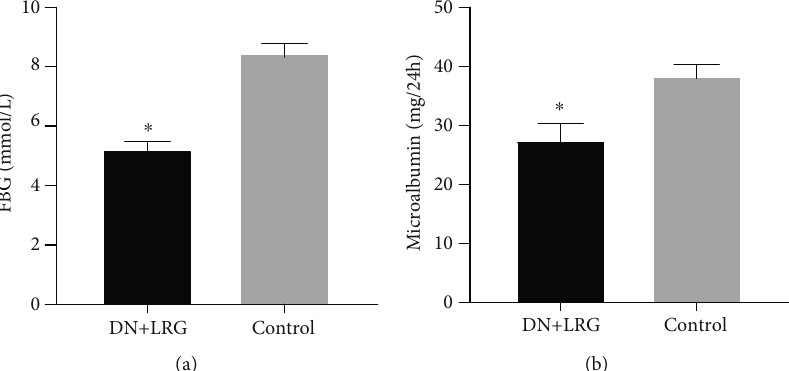
Figure 1: Fasting blood glucose and 24-hour microalbumin content. Control: diabetic nephropathy group; DN+LRG: diabetic nephropathy +liraglutide group; FBG: fasting blood glucose. ∗ P < 0 : 05 vs. the control.